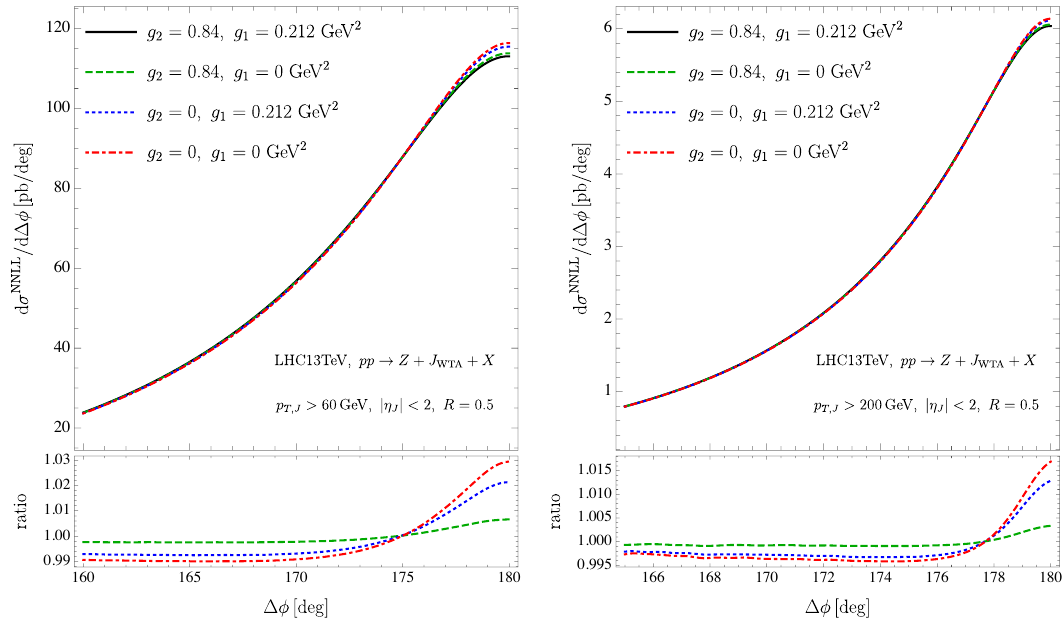
Figure 7. Variations of the nonperturbative parameters g 1 and g 2 in (5.11) for different jet transverse momentum cuts: p T,J > 60 GeV (left) and p T,J > 200 GeV